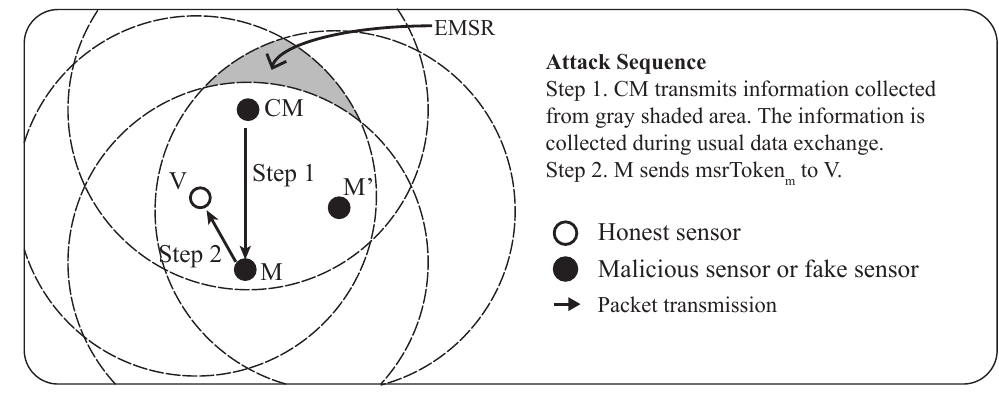
Figure 8. Colluding